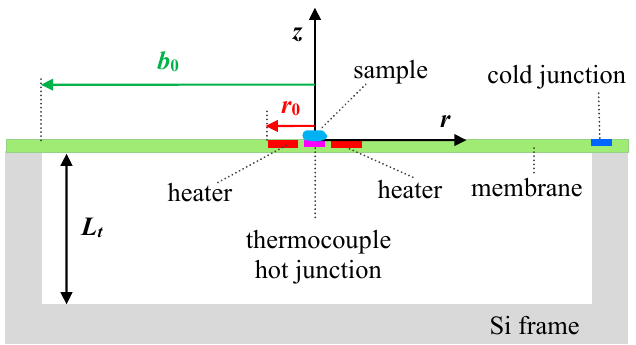
Figure 1. Schematic sectional view of a membrane-based nanocalorimeter, not to scale.